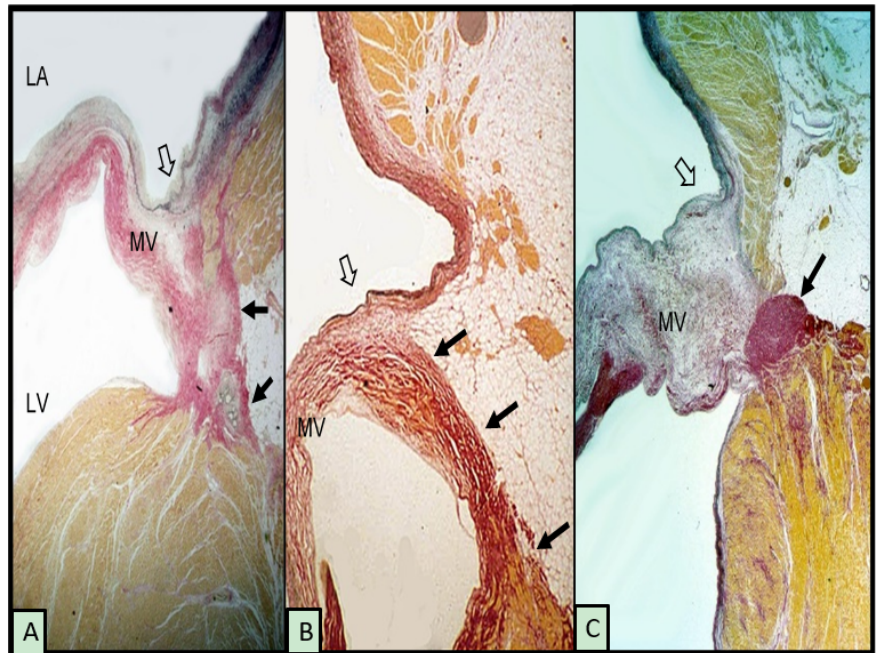
Figure 1. Histological sections from 3 hearts showing the posterior leaflet at the mitral hinge line (open arrows) and variations in mitral annular disjunction (small black arrows). ( A , B ) have normal leaflets. The myxomatous leaflet in ( C ) is hinged to the atrial wall and a cord-like annulus (arrow). The elastic van Gieson stain colors fibrous tissue red, myocardium yellow, and elastic dark blue or black. LV = left ventricle, LA = left atrium, and MV = mitral valve.